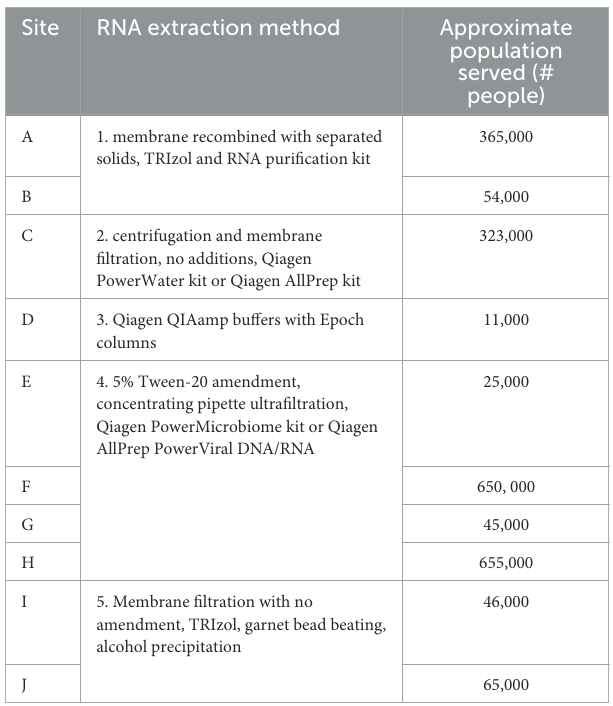
TABLE 1 RNA extraction methods and populations (2012 census) for sample sites in the study. Site RNA extraction method Approximate